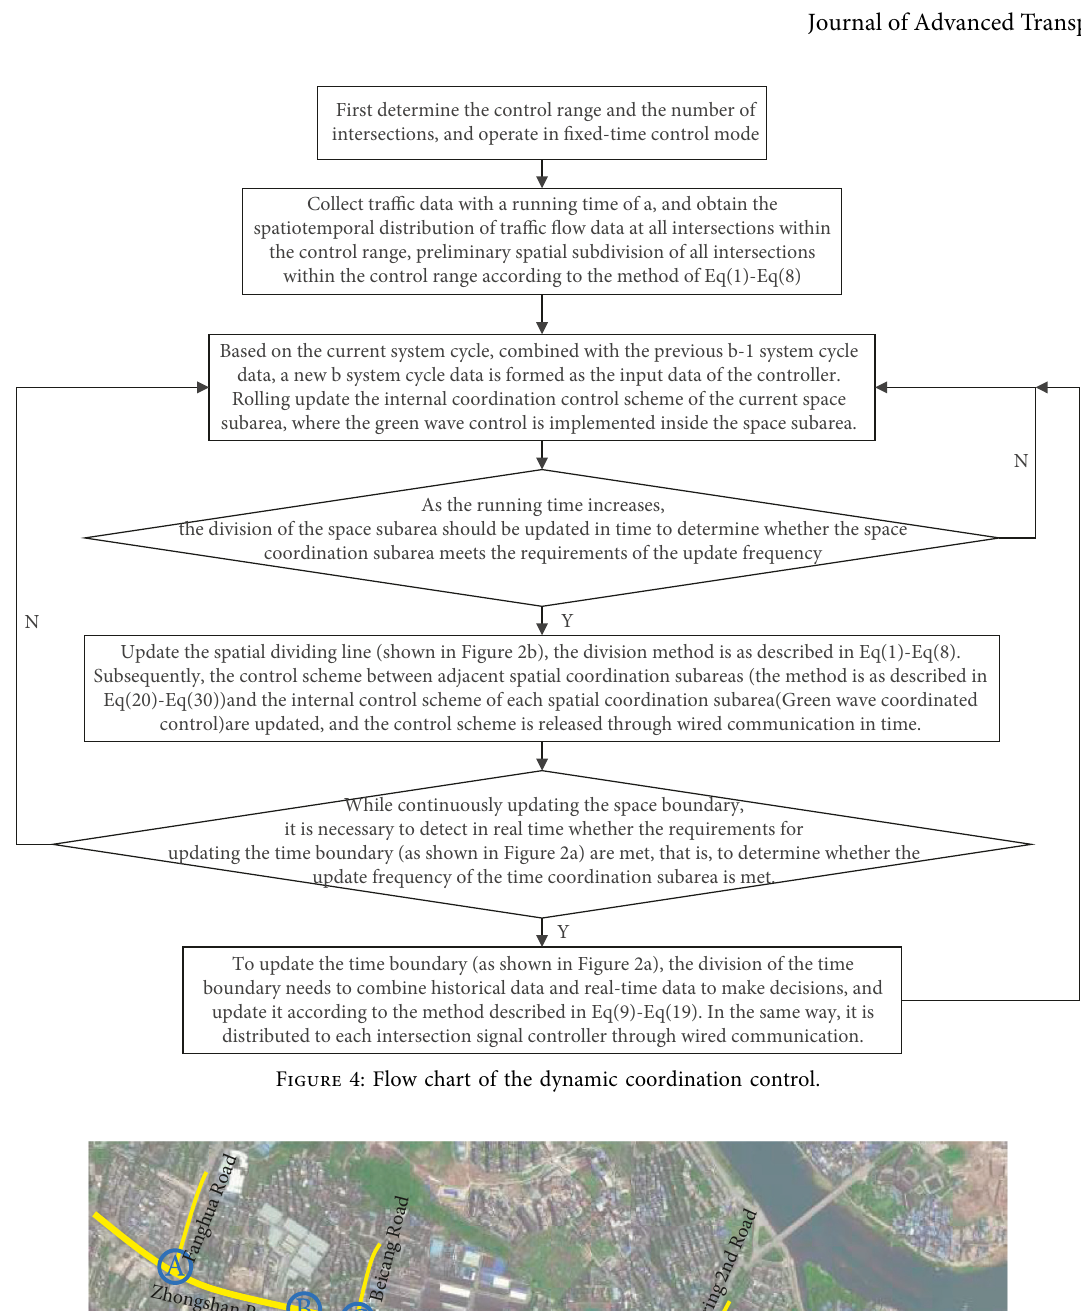
Figure 4: Flow chart of the dynamic coordination